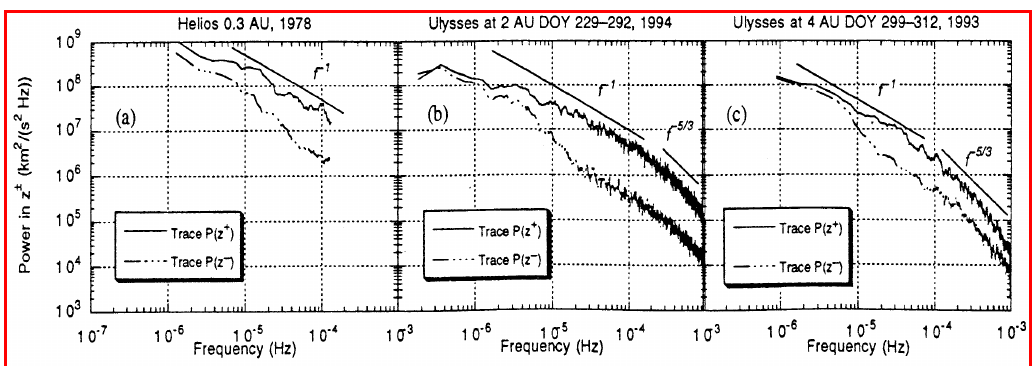
Figure 61: Trace of e + (solid line) and e – (dash-dotted line) power spectra. The central and right panels refer to Ulysses observations at 2 and 4 AU, respectively, when Ulysses was embedded in the fast southern polar wind during 1993 – 1994. The leftmost panel refers to Helios observations during 1978 at 0.3 AU. Image reproduced by permission from Goldstein et al. (1995a), copyright by AGU.